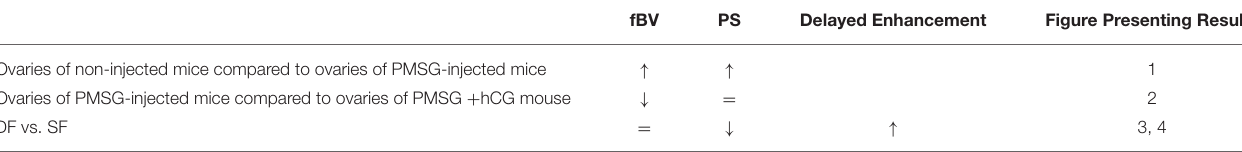
fBV PS Delayed Enhancement Figure Presenting Results